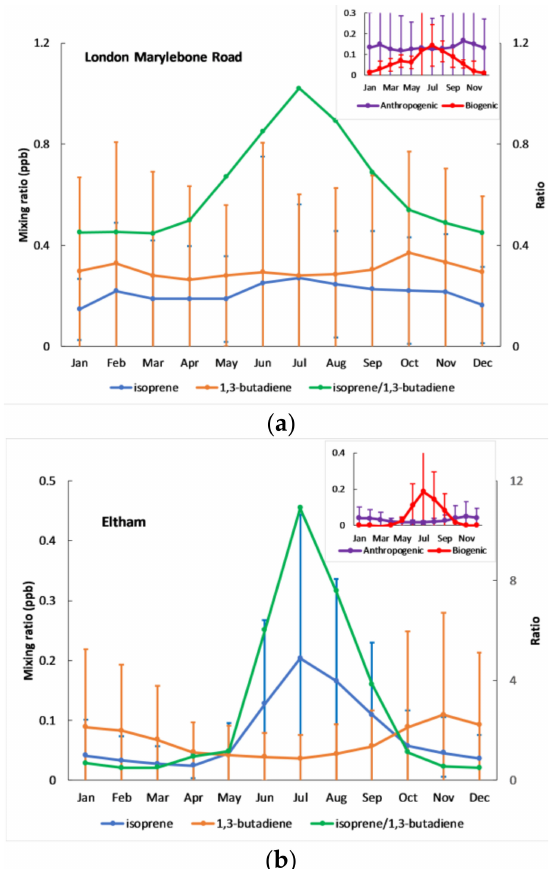
Figure 1. The monthly average mixing ratios of isoprene and 1,3-butadiene and their ratios for the period of 1997–2017 ( a ) London Marylebone Road ( n = 93,483 for isoprene and n = 137,462 for 1,3-butadiene), ( b ) Eltham ( n = 112,595 for isoprene and n = 127,360 for 1,3-butadiene). The biogenic and anthropogenic isoprene mixing ratios (in ppb) are shown in the subplots. Note: The error bar represents ± 1 SD of the whole data